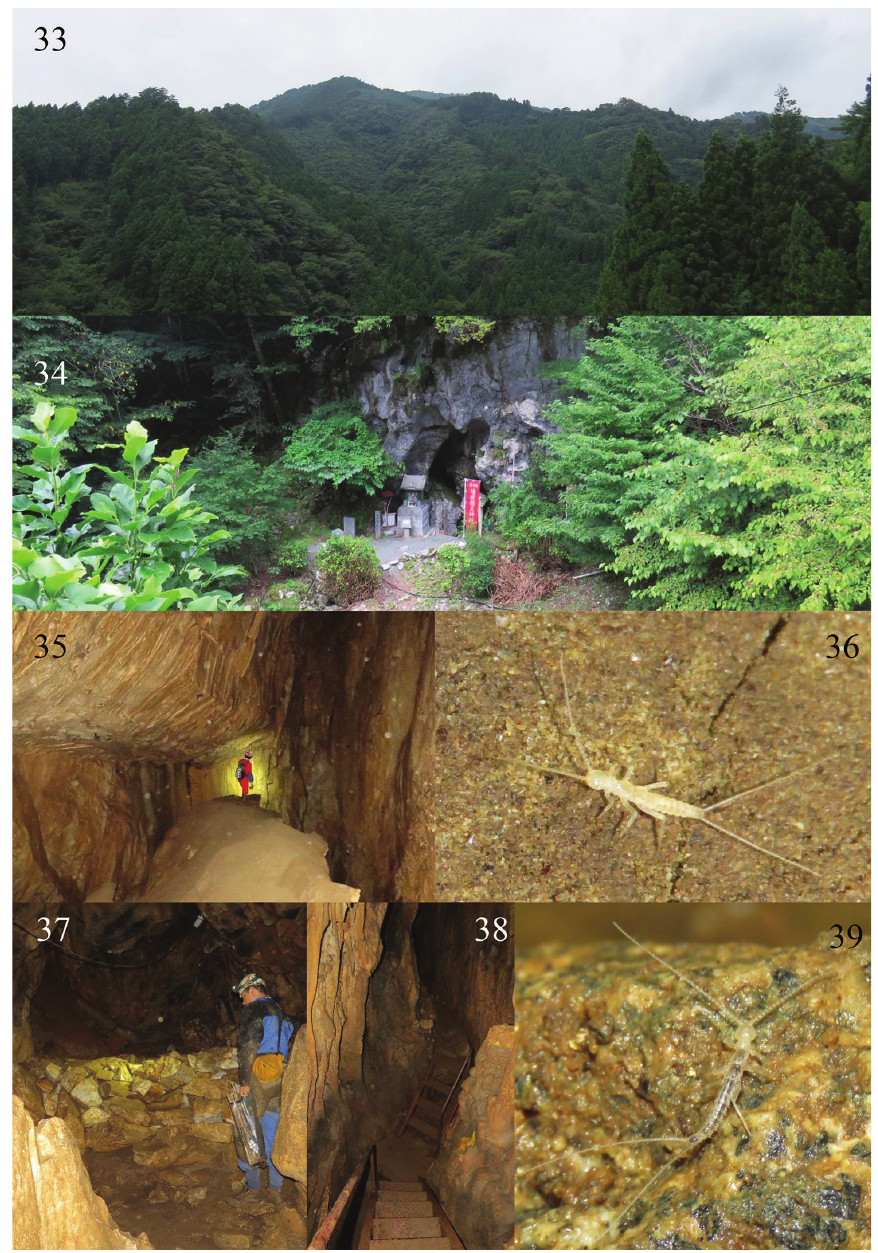
Figure 33–39. 33 Karst landscape in the area where Inaba-do cave is located 34 Inaba-do cave entrance 35 chamber located at the innermost area of Inaba-do cave 36 P. nipponica , living specimen from Inaba-do cave 37 stone wall built in Goya Daiichi Shonyu-do cave 38 mettalic stairs in Goya Daiichi Shonyu-do cave 39 P. nipponica , living specimen from Goya Daiichi Shonyu-do cave